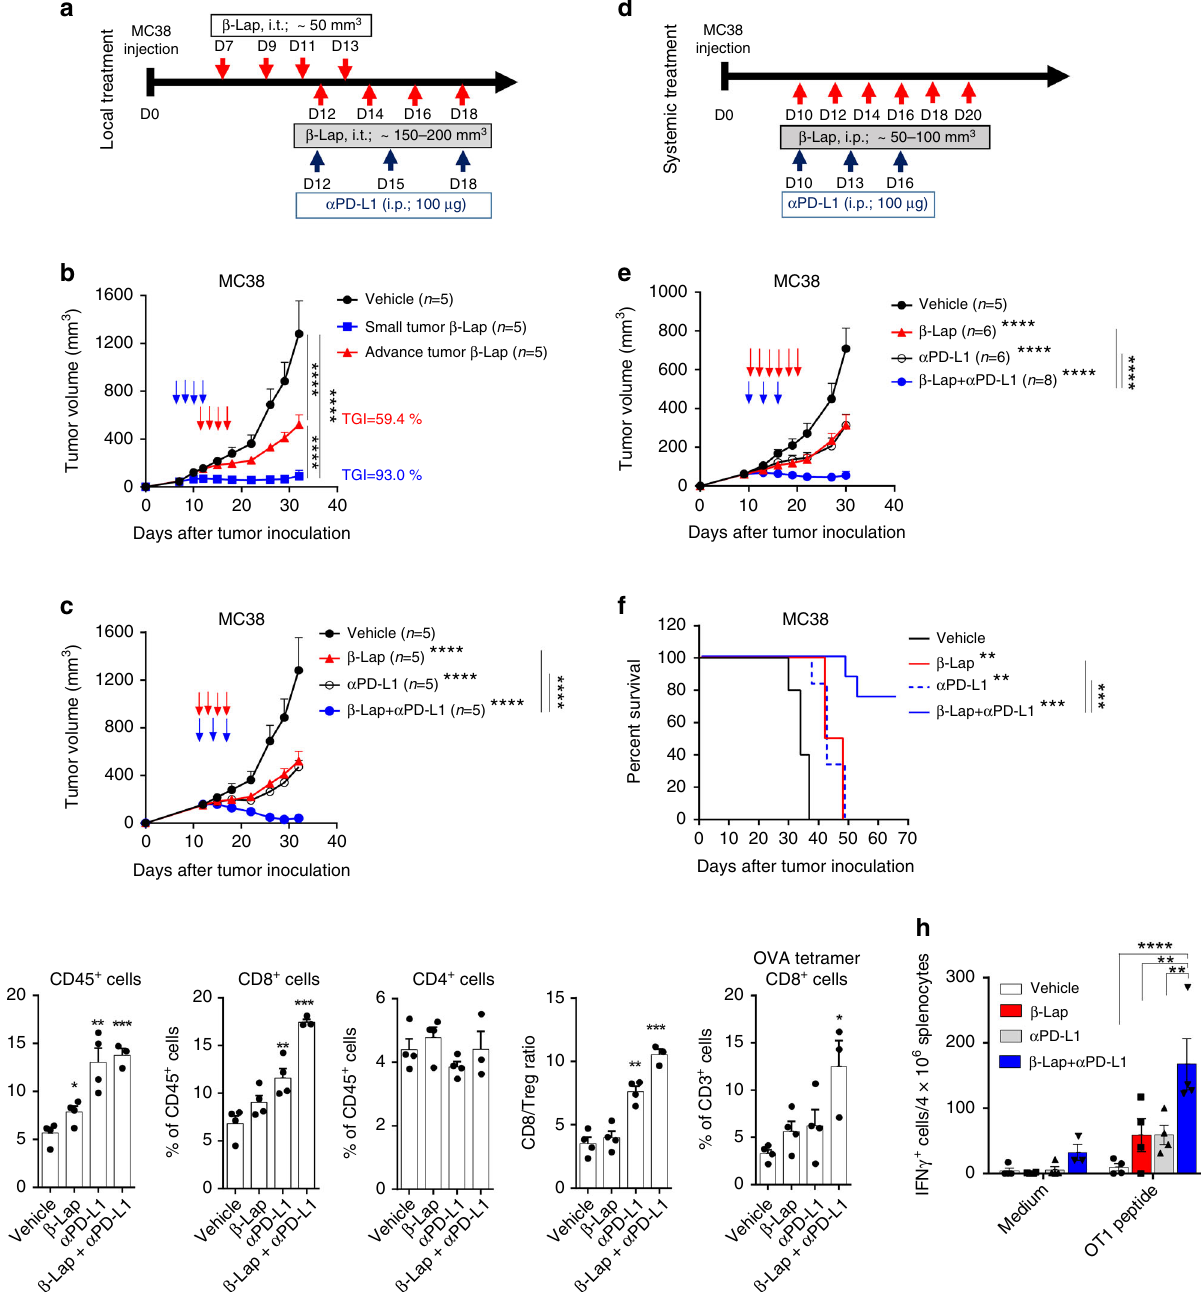
Fig. 6 β -Lap overcomes therapeutic PD-L1/PD-1 blockade resistance. a Treatment schema for local β -lap treatment-based combinative therapy in panel b and panel c . b , c 6 × 10 5 MC38 tumor cells were s.c.inoculated into the fl ank of C57BL/6 mice ( n = 5/group). Mice bearing small tumor (about 50 mm 3 , in b ) or advanced tumor (about 150 – 200 mm 3 , in c ) were locally treated with β -lap (15 mg/kg, i.t.) for four times with or without anti-PD-L1-based checkpoint blockage. Tumor growth was monitored twice a week, and numbers of tumor-free mice after treatment were shown. d Treatment schema for systemically β -lap treatment-based combinative therapy in panels e and f . e 6 × 10 5 MC38 tumor cells were s.c. inoculated into the fl ank of C57BL/6 mice ( n = 5 for vehicle treatment group; n = 6 for β -lap and vehicle + α PD-L1 groups; n = 8 for β -lap + α PD-L1 treatment group). Tumor-bearing mice (about 50 – 100 mm 3 ) were systemically treated with β -lap (30 mg/kg, i.p.) for six times with or without anti-PD-L1-based checkpoint blockade. Tumor growth was monitored twice a week, and numbers of tumor-free mice after treatment were shown. f Survival curve for MC38 tumor-bearing mice with combinative treatment in panel e . g , h C57BL/6 mice bearing MC38-OVA tumor (about 150 mm 3 , n = 4/group) were locally treated with β -lap (15 mg/kg, i.t.) every other day for four times or anti-PD-L1 (100 μ g, i.p.) for three times, alone or combination. Twelve days after fi rst treatment, tumor-in fi ltrating CD45 + cells and lymphocytes were analyzed by fl ow cytometry in g , and OT-1 antigen-speci fi c T cells in the spleen were determined by IFN γ ELISPOT assay in h . Data are shown as mean ± SEM from two to three independent experiments. * p < 0.05, ** p < 0.01, *** p < 0.001, **** p < 0.0001 determined by two-way ANOVA in b , c , e , g and h or log-rank test in